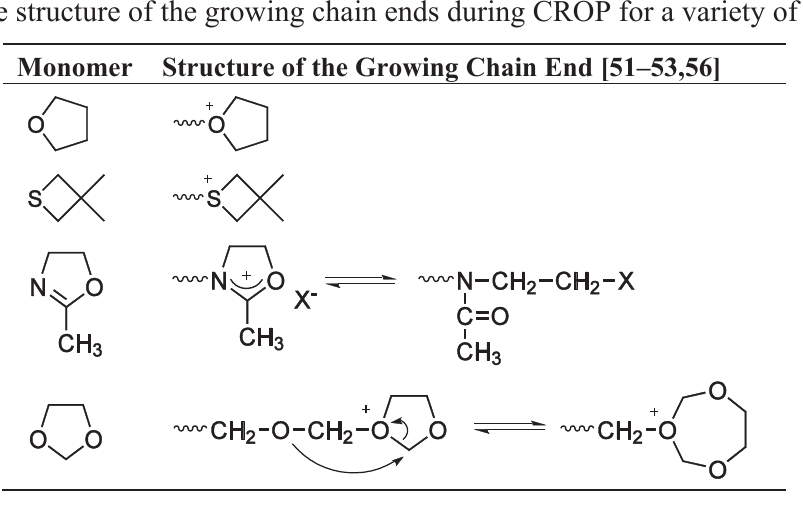
Figure 28. Termination of CROP by phenolate to allow quantitative determination of the growing chains.